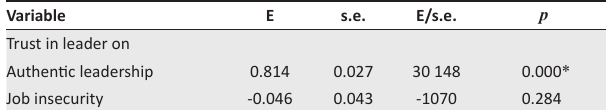
TABLE 4 : Standardised regression coefficients of authentic leadership and job insecurity in predicting trust in the leader. Variable E s.e. E/s.e. p Trust in leader on